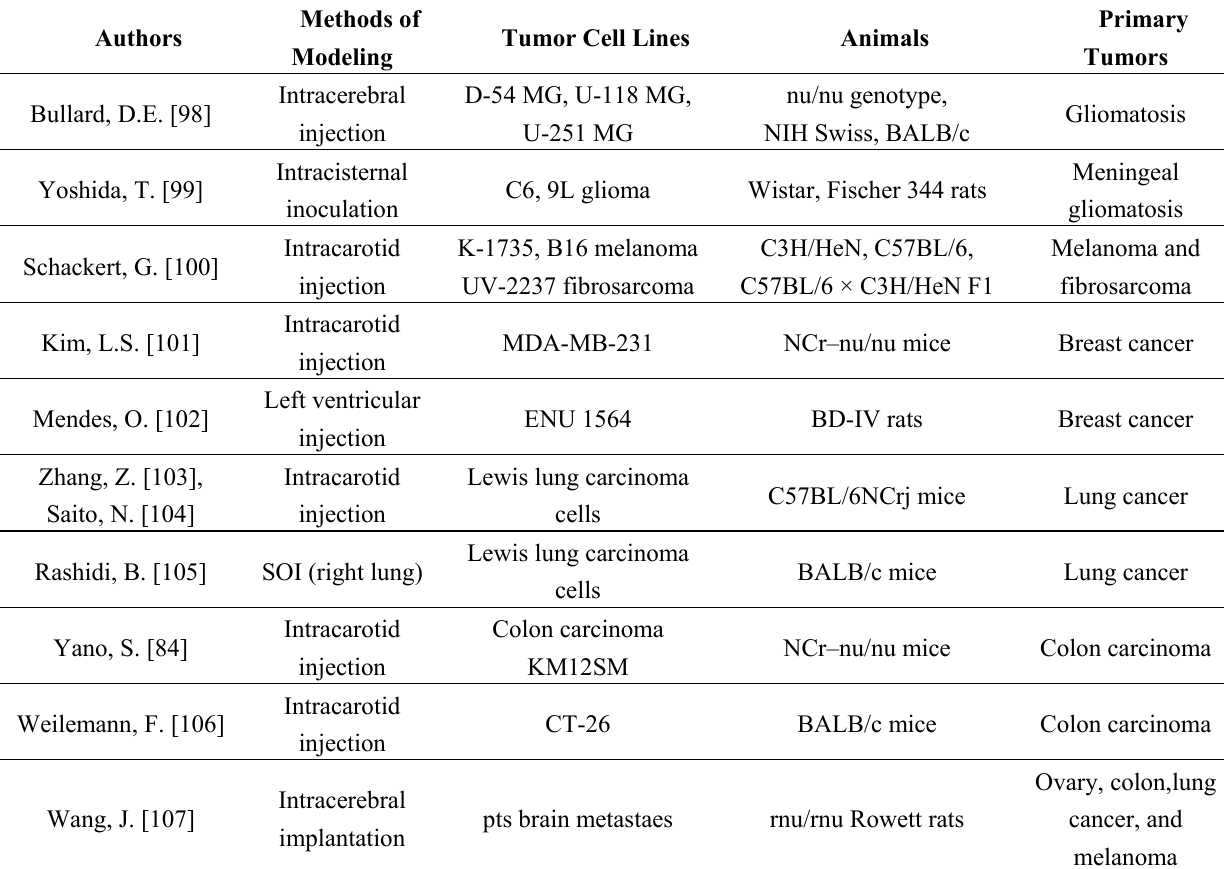
Table 2. Methods of animal models for brain